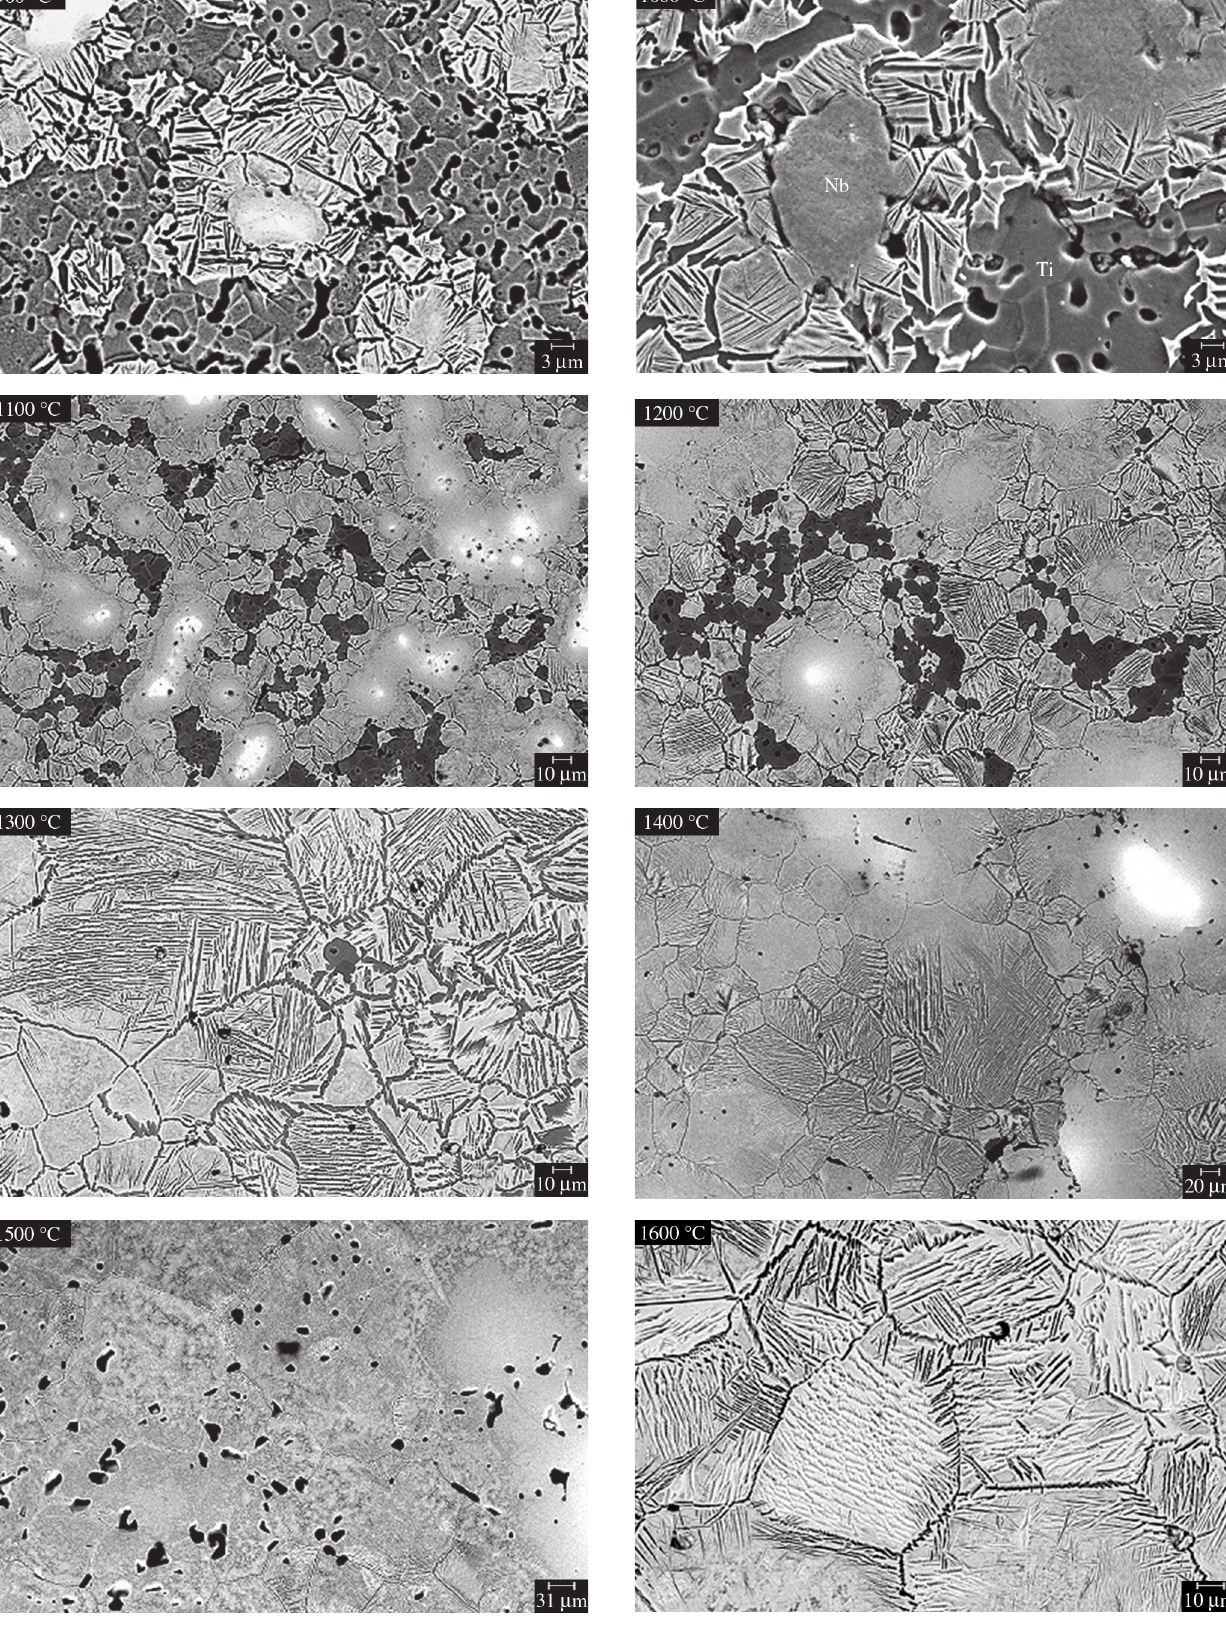
Figure 1. Microstructural evolution of the BE-Ti-35Nb during sintering. All samples were sintered at the nominal temperature for 1 hour and heating rate equal to 20 °C/min -1